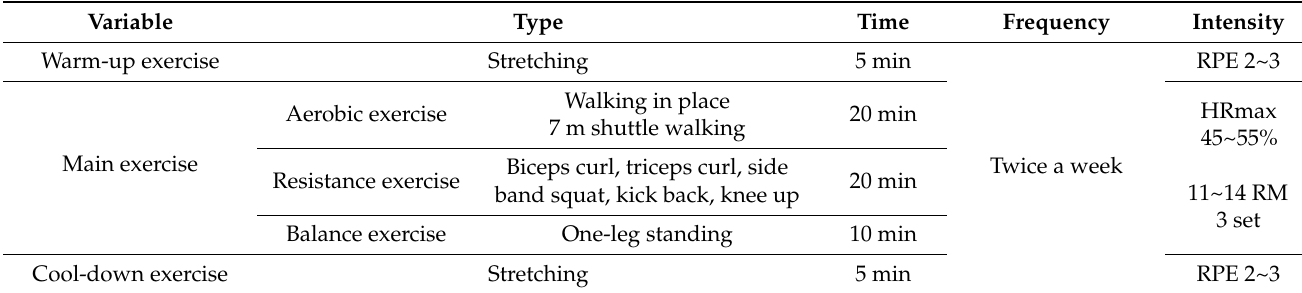
Table 2. The 6-month complex exercise program for the elderly aged over 75 years.